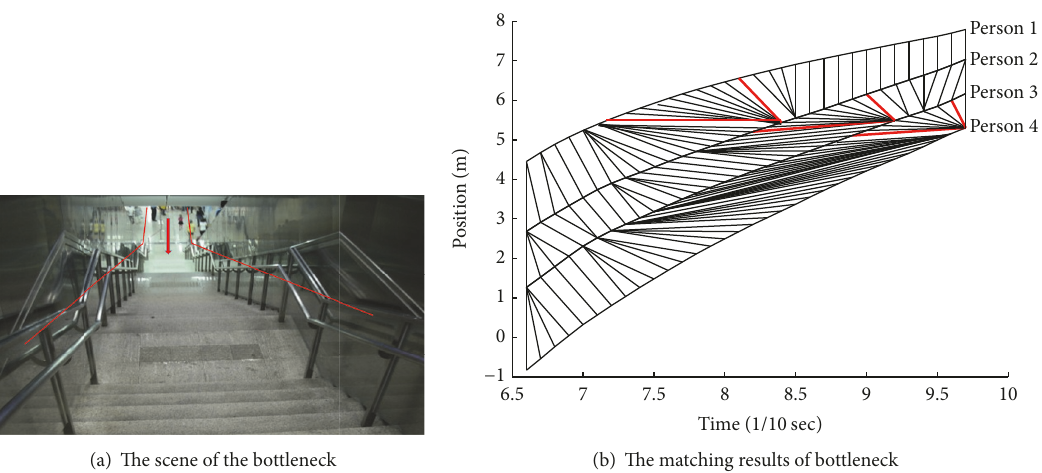
Figure 2: The matching results in bottleneck using DTW algorithm.